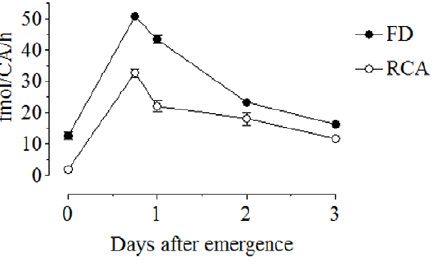
Figure 9. Biosynthesis of JH III invitro in sugar-fed females. CA- CC complexes from sugar-fed females were dissected at different times after emergence, incubated for 4 h, extracted and analyzed by HPLC- FD. Radio chemical analysis (RCA) data are from Li et al. [31]. Data N represent the means 6 SD of three independent experiments. HPLC-FD: ), RCA: ( # ). (